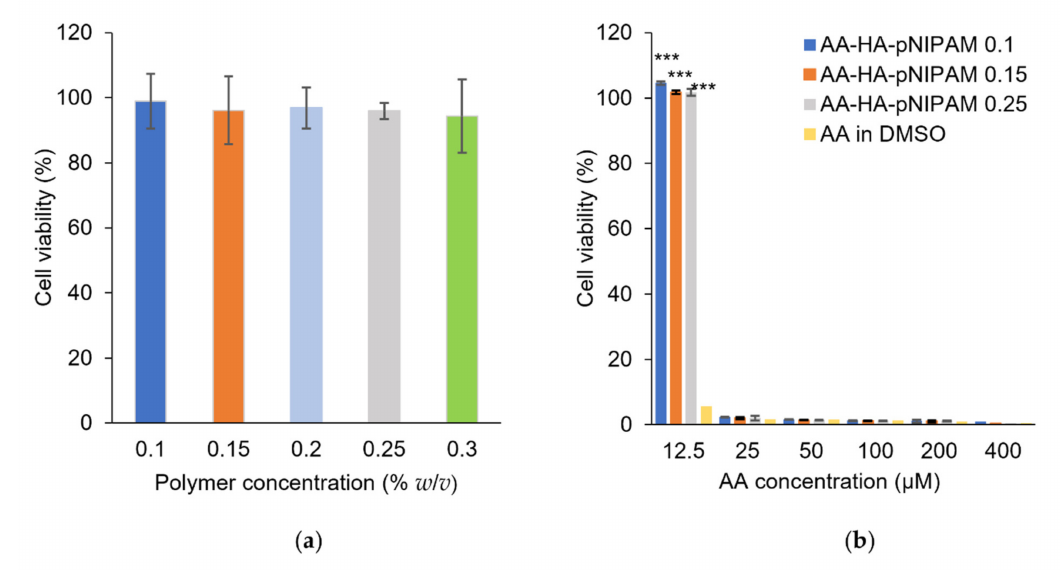
Figure 5. PrestoBlue assay showing the relative non-toxic effects of ( a ) drug-free nanogel, and ( b ) AA-loaded HA-pNIPAM nanogels to L-929 cells (mean ± SD, n = 3). *** p < 0.001 vs. AA in